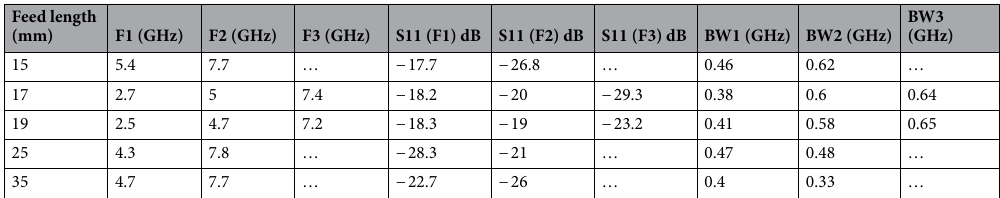
Table 9. Electrical properties of Antenna4 topology using a feedline length as a parameter.